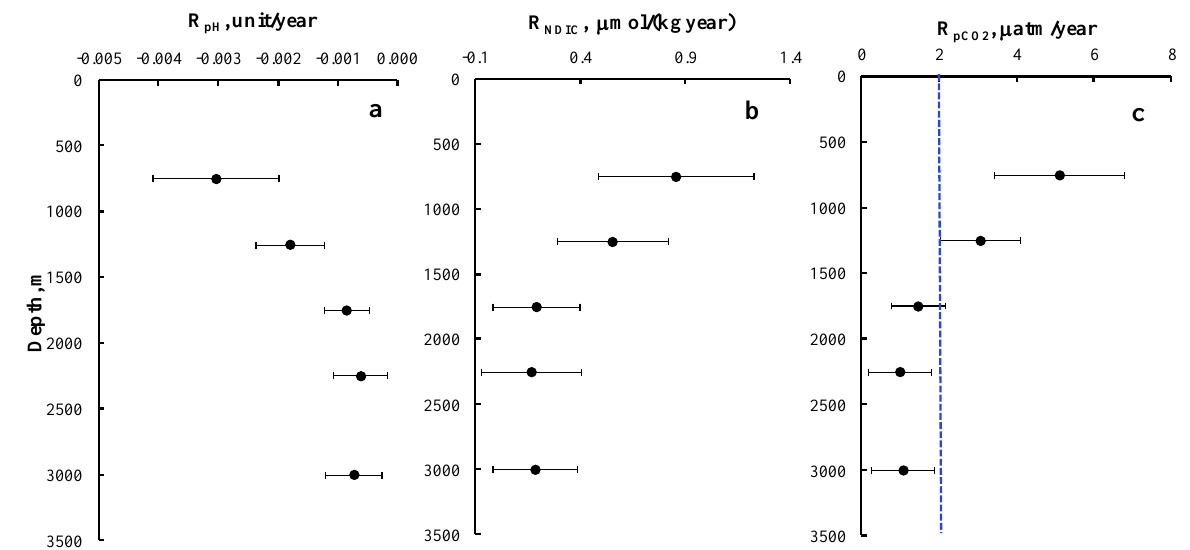
Figure 10. Rates of temporal variability of the averaged carbonate system parameters in the JES as a function of depth. ( a ) R [pH] , pH unit/year; ( b ) R [NDIC] , µmol/(kg·year); ( c )—R [pCO2] , µatm/year. Bars are 3·s.d. of rates estimated by LSM with the 95% confidence interval. The dashed line shows the rate of expected changes based on atmospheric CO 2 alone.